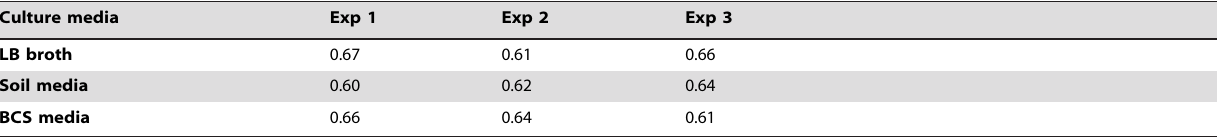
Specific growth rate constant (k) of B.cenocepacia P2: lnN0-lnN1=k (t0–t1) k . 0 growth; k=0 critical point; k , 0